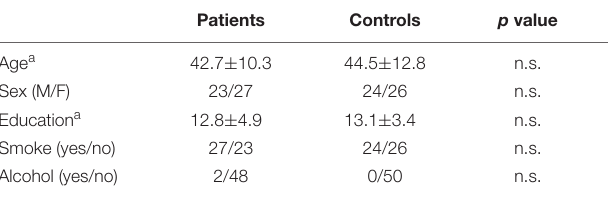
TABLE 1 | Baseline demographic variables in patients and